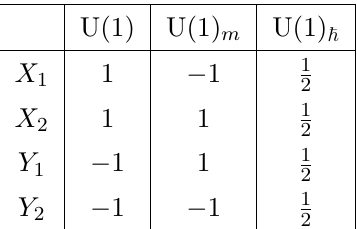
Table 1. Gauge and (cid:13)avour charges of chiral multiplets in the case k = 1 and N = 2.